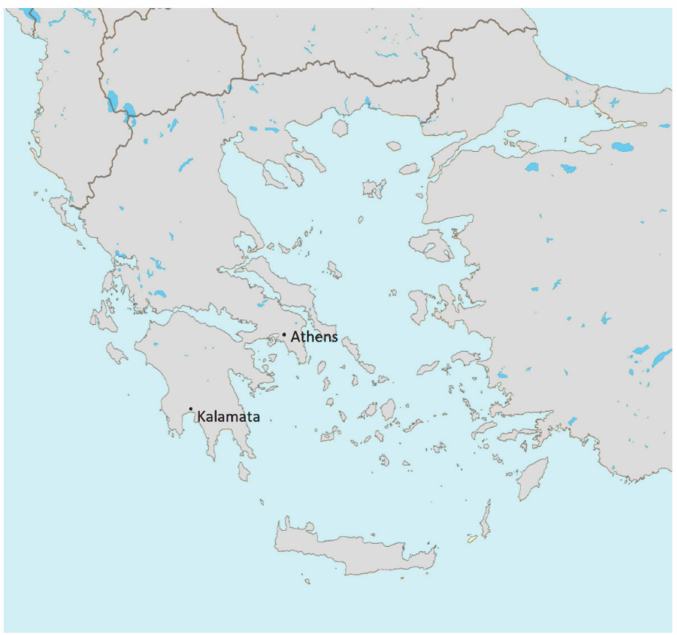
Figure 1. Map of Greece with the experimental